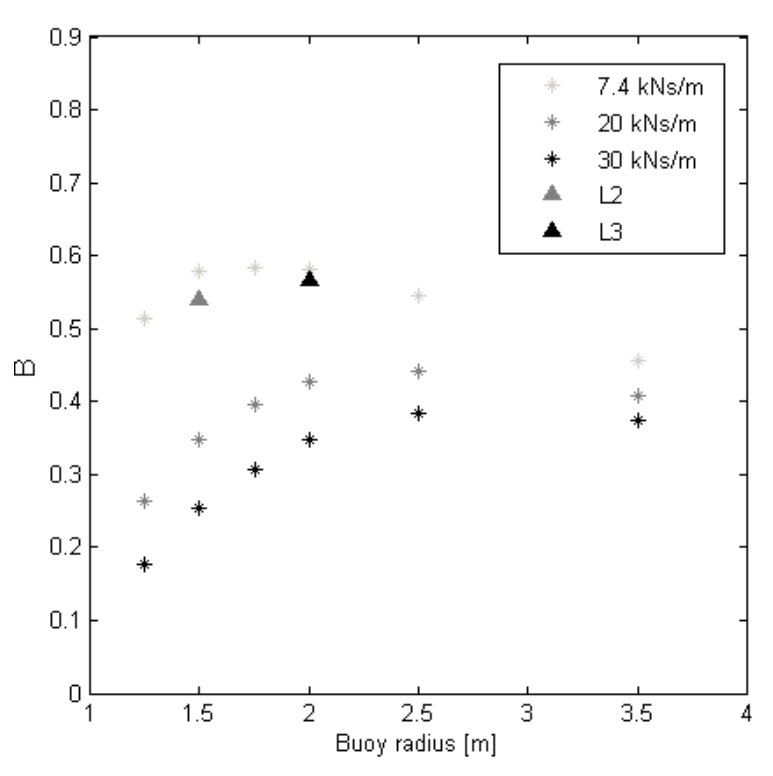
Figure 7. Velocity ratio B as a function of buoy radius and draft. The radius of the simulated buoy is shown, the corresponding draft to each simulated buoy has been calculated assuming = 2500 kg. Simulated results of B for the WECs L2 and L3 are a constant buoy mass, m b shown as triangles.